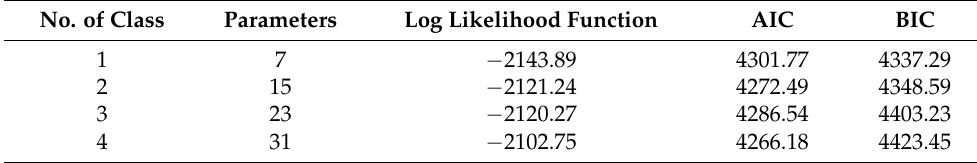
Table 3. Statistics for latent-class regression models ( happiness sense ). No. of Class